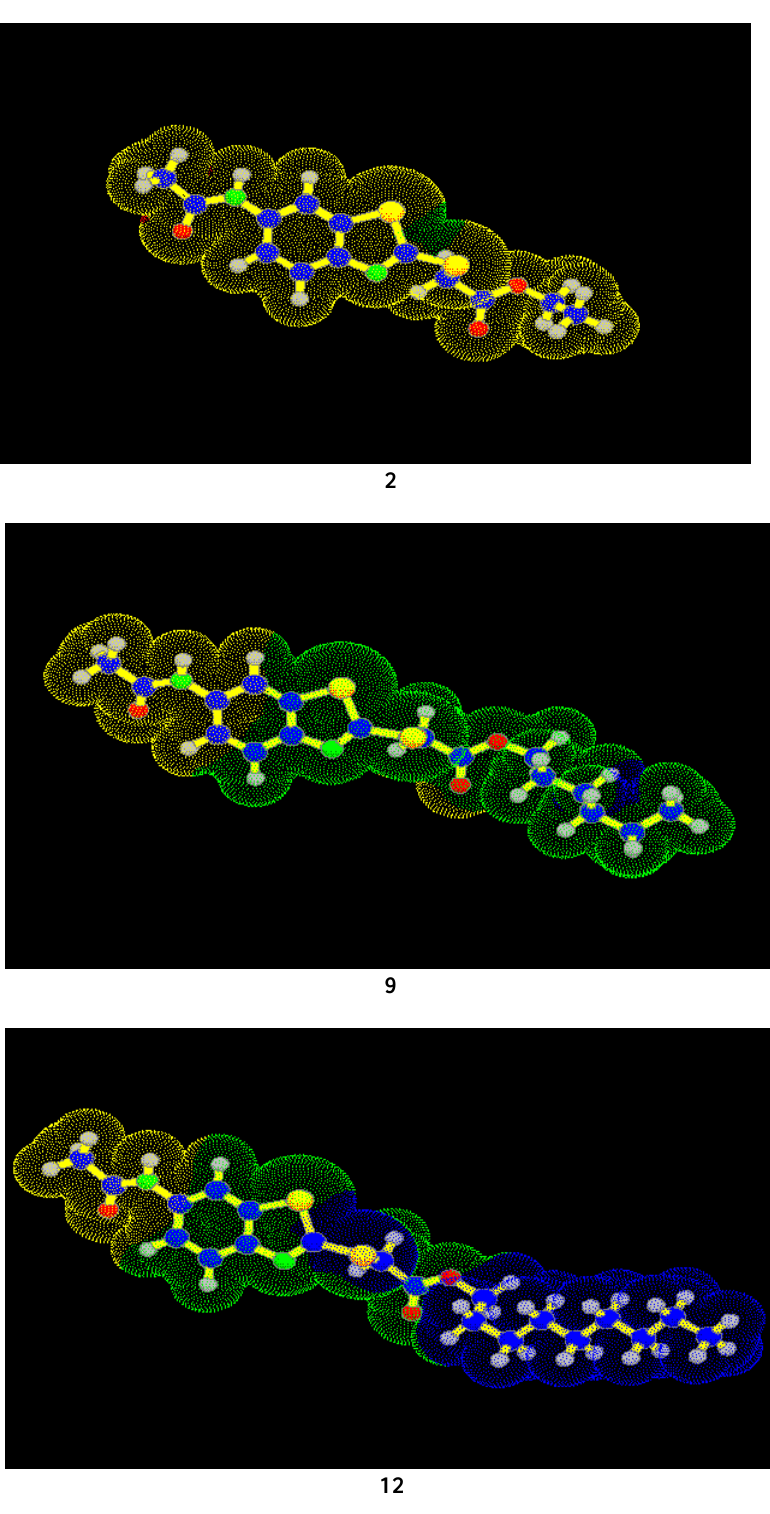
Figure 1. Distribution of lipophilicity on the Van der Waals surface (the highest value of the lipophilicity is in the blue colour area) for compounds 2 , 9 and 12